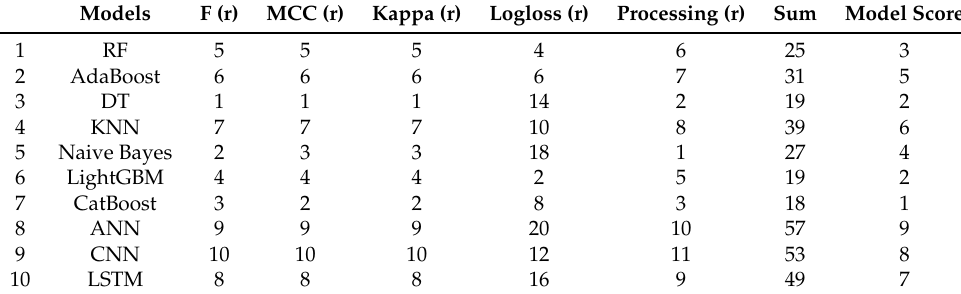
Figure 10. Processing time for all models using Spark. Table 10. Model performance for binary classification.